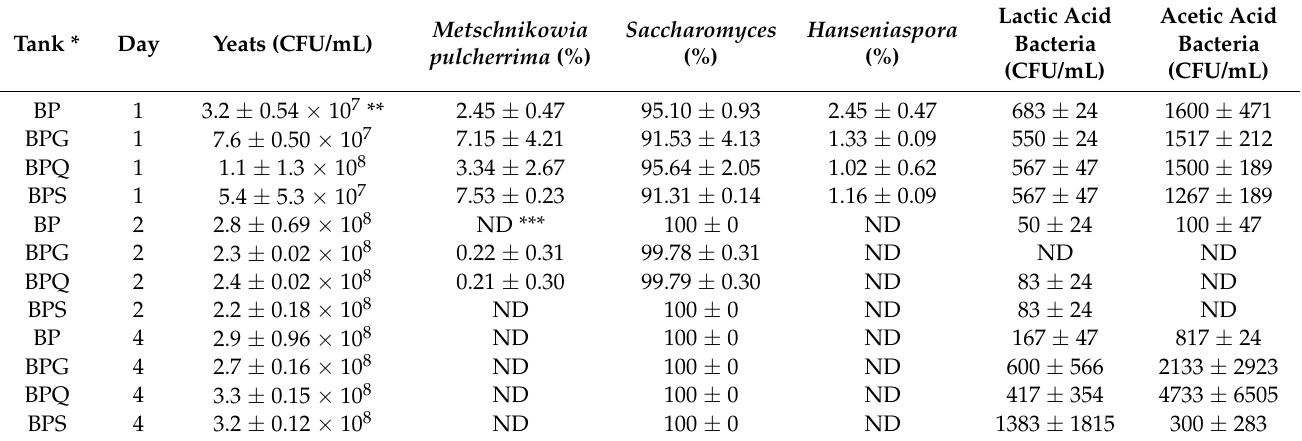
Table 1. Microbial populations during